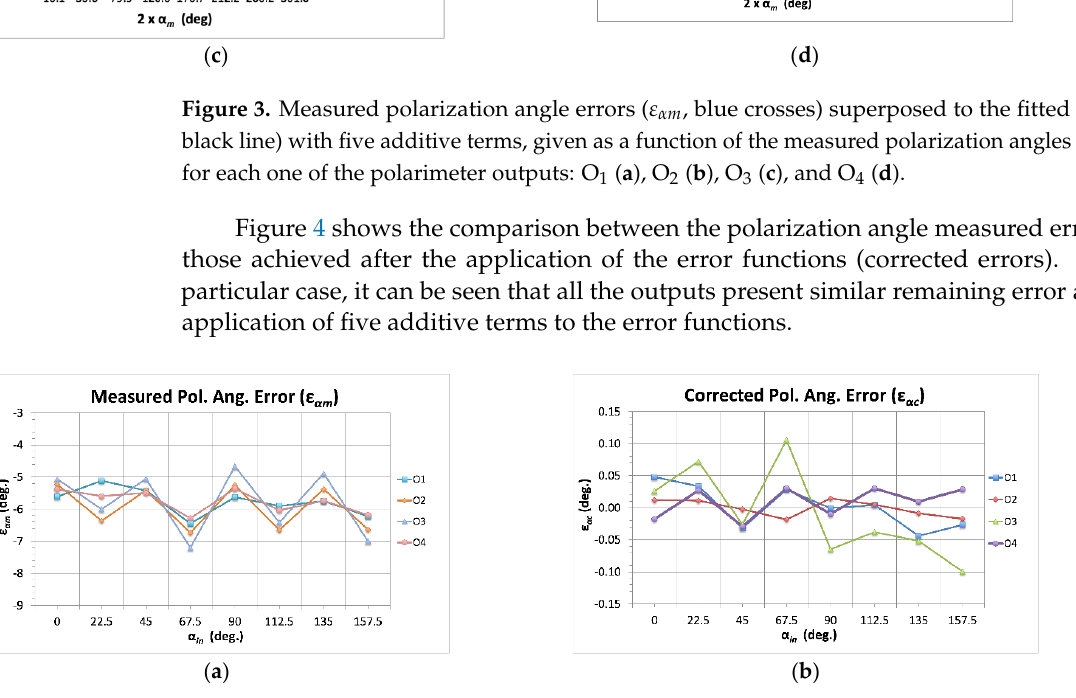
Figure 4. Measured polarization angle errors ( ε α m , ( a )) compared to the corrected ones ( ε α c , ( b )). The calibrated errors are represented here as a function of the input polarization angles ( α in